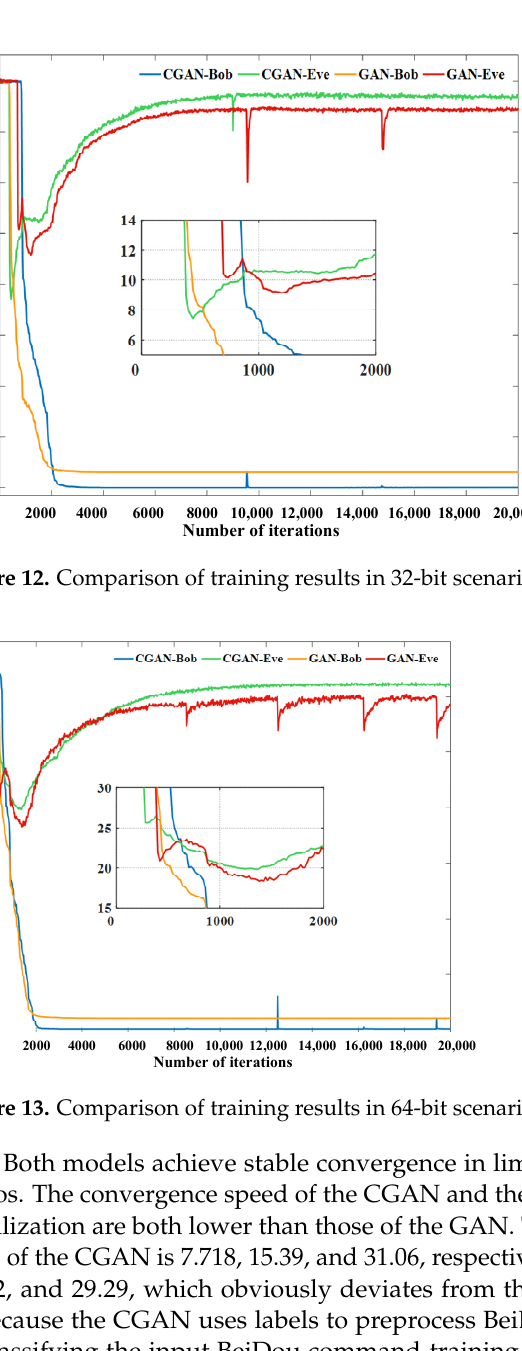
Figure 11. Comparison of training results in 16-bit scenarios.